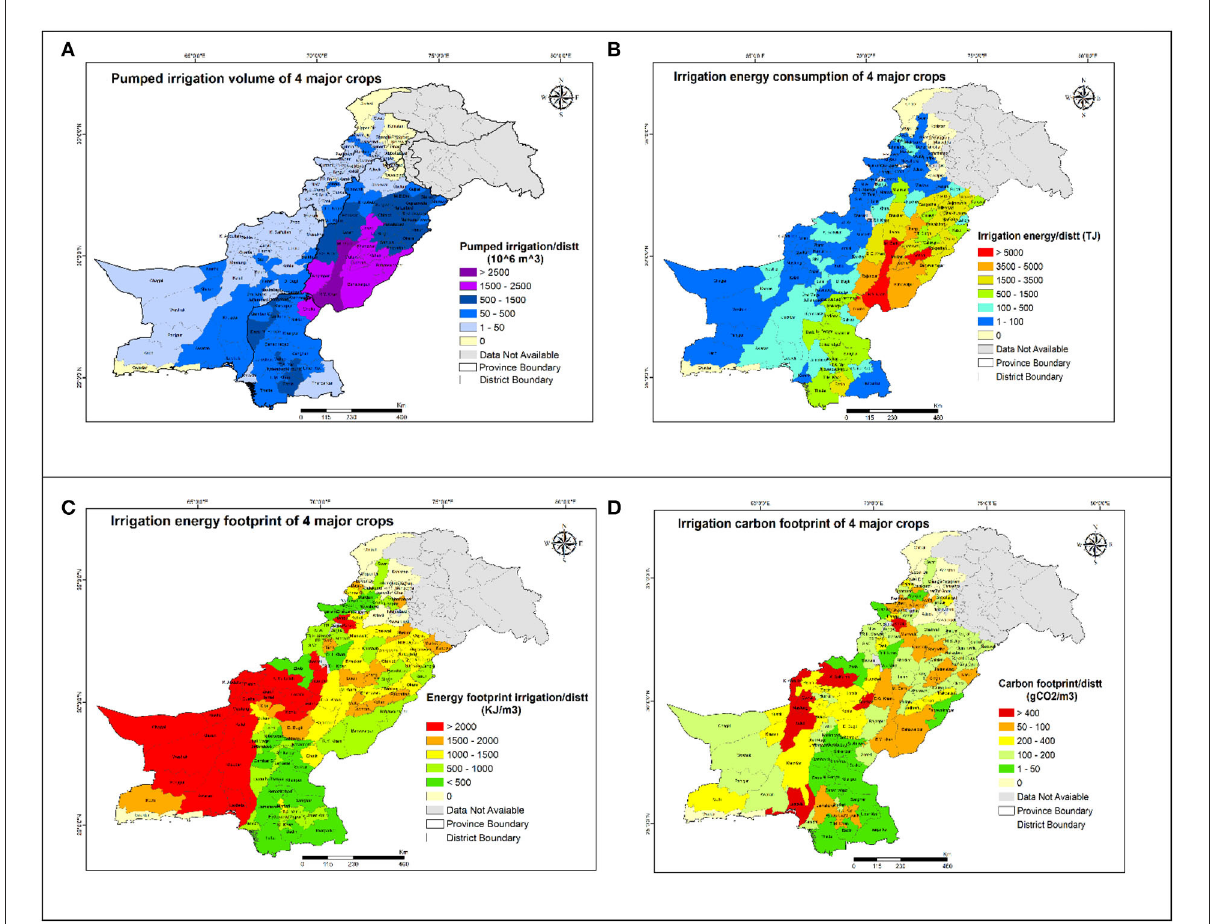
FIGURE5 (A–D) Pumped irrigation volumes, energy for irrigation supply, and energy and carbon footprints for the major crops (wheat, rice, sugarcane, and cotton) per district in Pakistan for the period 2016–2017. (A) Shows the annual pumped surface and groundwater irrigation volume, (B) shows the total energy consumption (diesel and electric) for irrigation supply of the major crops per district, (C) shows the energy footprints per unit of irrigation supply per district, and (D) shows the carbon footprints per unit of irrigation supply per